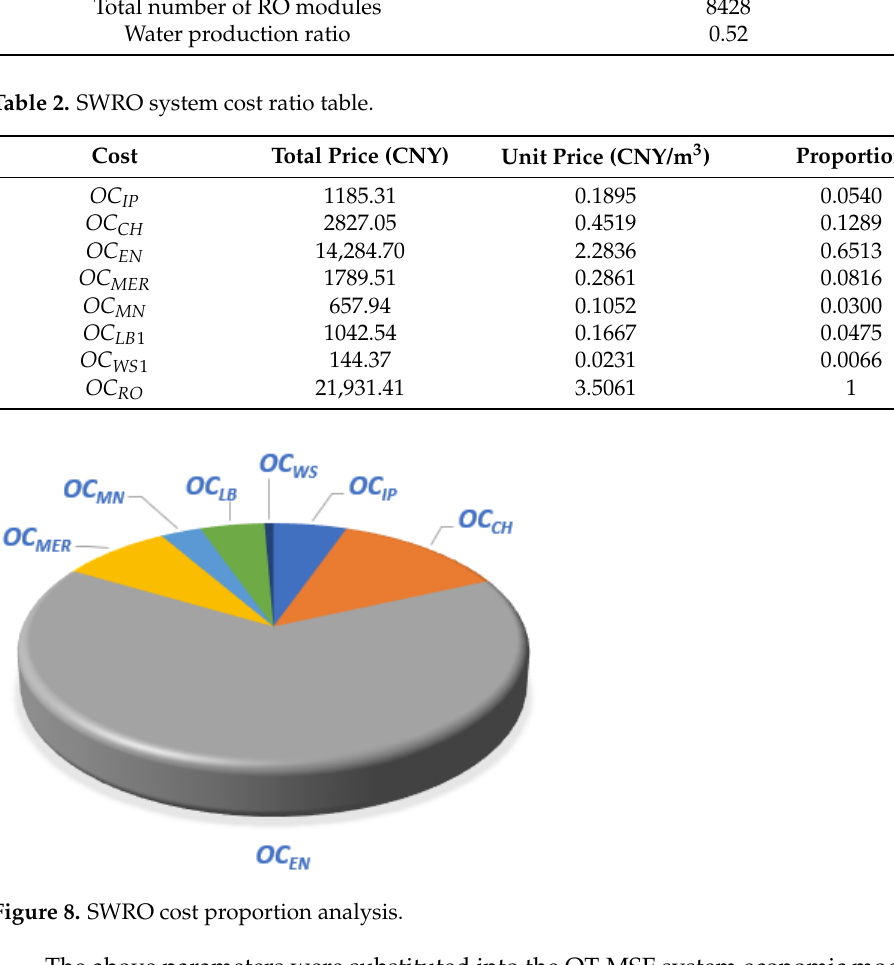
Table 2. SWRO system cost ratio table.